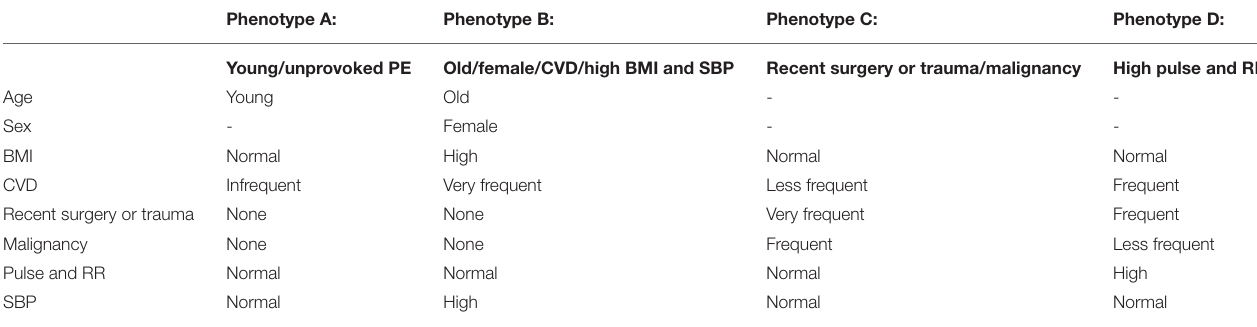
TABLE 5 | Summary of syncope phenotypes identified using principal component analysis-based cluster